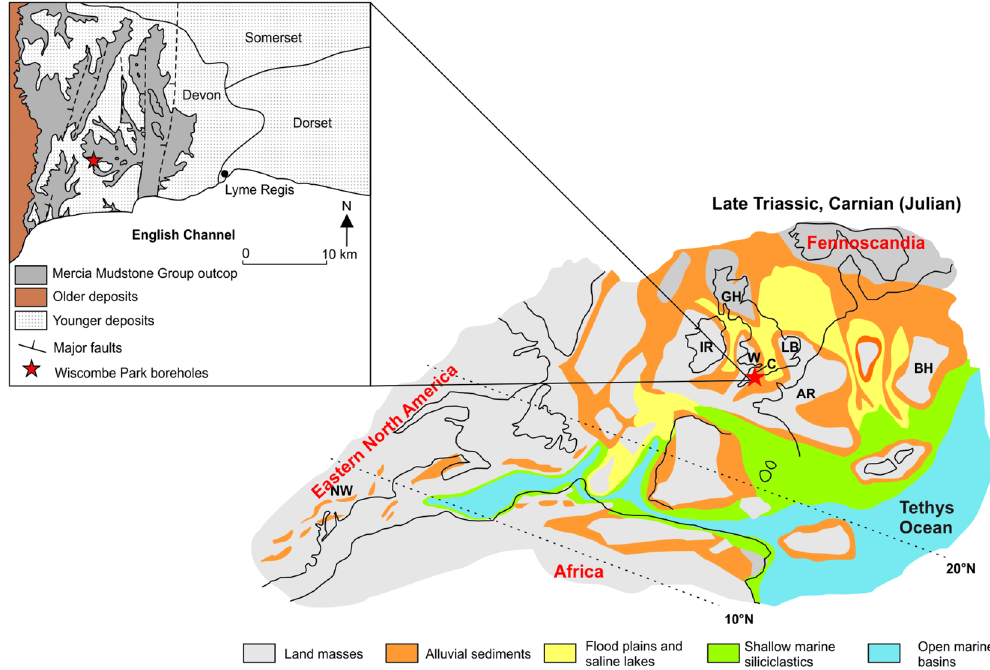
Figure 1. Palaeogeographic map of western Europe, eastern North America and Africa during the Carnian adapted from 44 , using CorelDraw Graphics Suite X7 (http://www.coreldraw.com/de/) Copyright (c) 2015 [MARUM] and its licensors. All rights reserved. Insert shows the distribution of the Mercia Mudstone Group and the location of the WP boreholes. Abbreviations: GH (Grampian High), IR (Ireland), W (Wales), C (Cornubia), AR (Armorica), LB (London Basin), BH (Bohemian-Vindicelian High) and NW (Newark